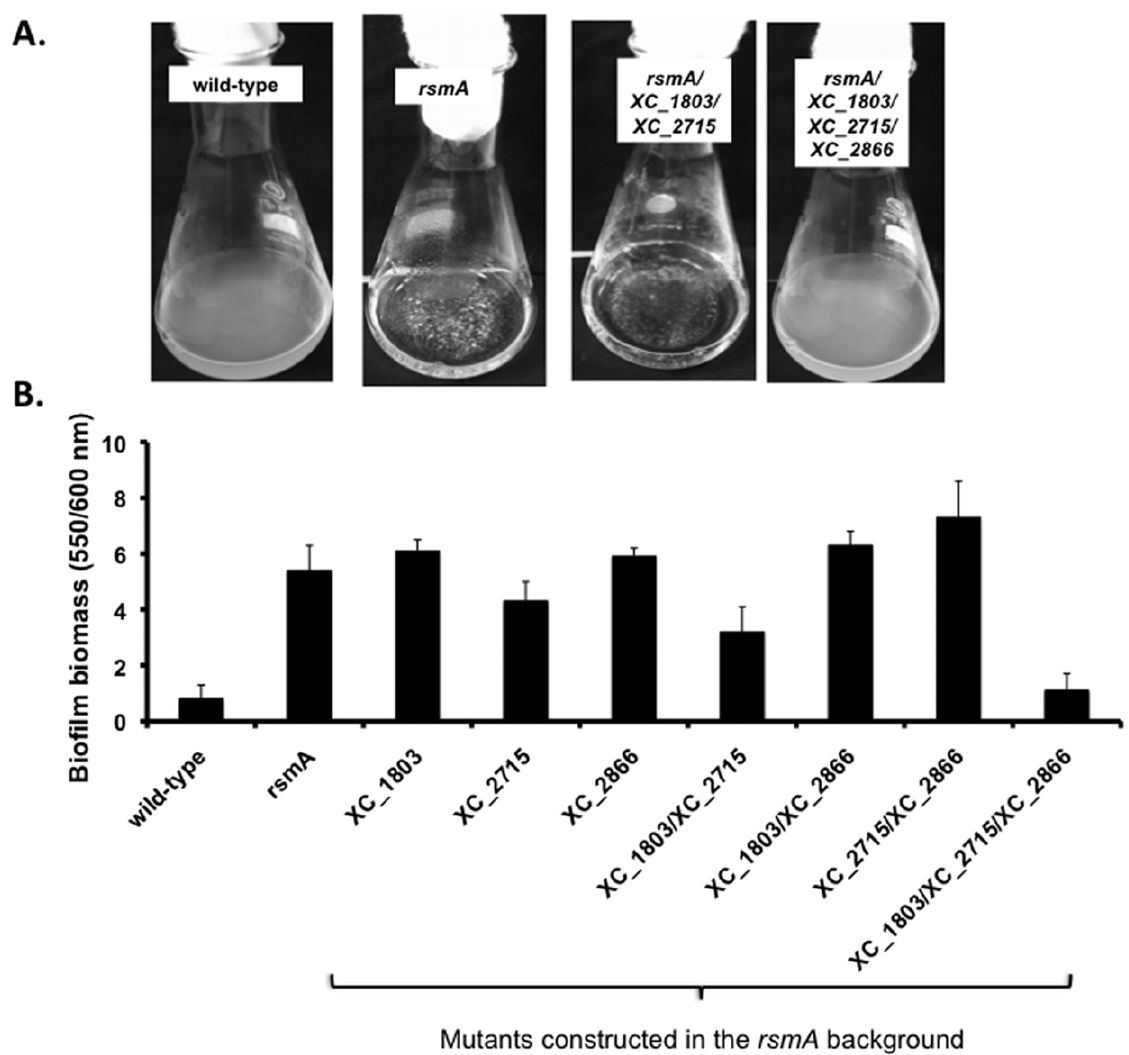
Figure 6. Combinatorial mutation of three genes encoding GGDEF domain proteins in the rsmA mutant background prevents aggregation and reduces biofilm formation towards wild-type. (A) A triple disruption of XC _ 1803 , XC _ 2715 and XC _ 2866 background prevents aggregation of the rsmA mutant, although single or double mutants (such as XC _ 1803 / XC _ 2715 illustrated) have little or no effect. (B) A triple disruption of XC _ 1803 / XC _ 2715 / XC _ 2866 in an rsmA mutant background leads to reduction in biofilm to a level similar to that of the wild-type strain as measured by the crystal violet staining assay (see Methods for details). In contrast mutation of XC _ 1803 , XC _ 2715 and XC _ 2866 alone or in pairwise combination has little or no effect on biofilm formation in the rsmA mutant. Values presented are the means and standard deviations from triplicate measurements (three biological and three technical replicates).